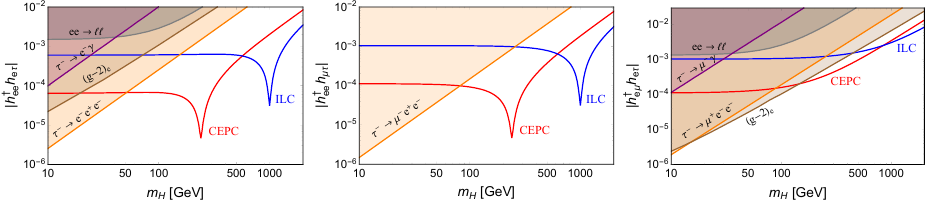
Figure 5. Prospects of | h † ee h e τ | ( left ), | h † ee h µτ | ( middle ), and | h † e µ h e τ | ( right ) from searches of e + e − → e ± τ ∓ , µ ± τ ∓ at CEPC 240 GeV with 5 ab − 1 (red) and ILC 1 TeV with 1 ab − 1 (blue). The shaded regions are excluded by the corresponding limits. See text for more details. Figure from Ref.